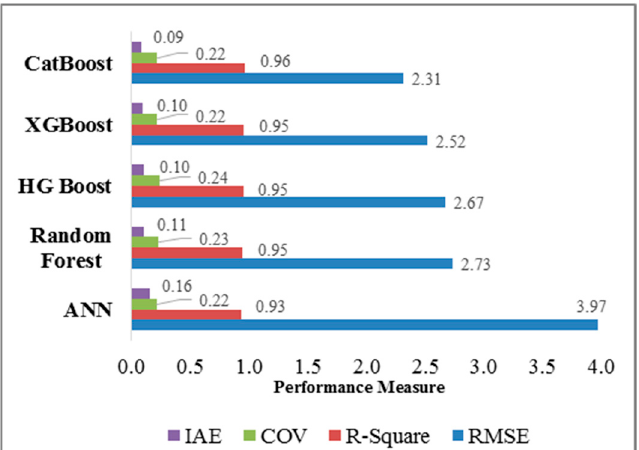
Figure 7. Consolidated performance analysis.